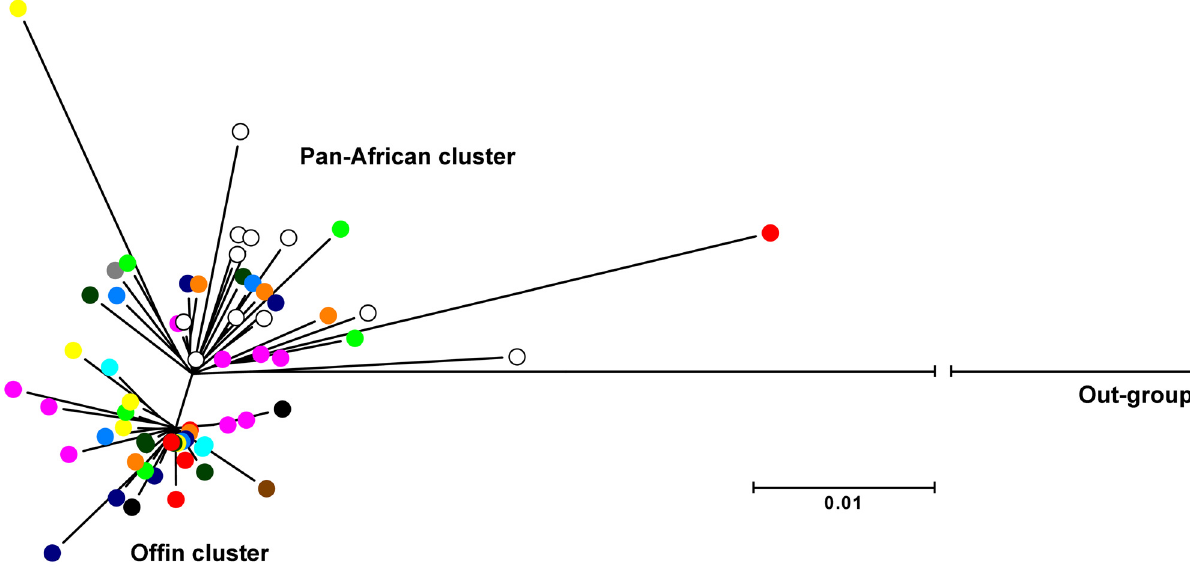
Fig 4. Phylogenetic reconstruction of HBV/E sequences. A maximum-likelihood phylogenetic tree based on the pre-S/S gene region sequence (1,200 bp) was constructed using the Kimura 2-parameter +G model [41] embedded in MEGA6 [42]. While HBV sequences obtained in this study are indicated as multicolored dots (according to village of residence), HBV genotype E sequences retrieved from GenBank are depicted as empty circles (accession numbers (origin): AB205192 (Ghana), AB106564 (Ghana), DQ060830 (Madagascar), AB201290 (Benin), AB205188 (Ghana), AB091255 (Côte d'Ivoire) AB091256 (Côte d'Ivoire), HM363611 (Nigeria), FN594765 (Niger), AB205191 (Ghana), AB205190 (Ghana)). The sequence of the genotype D AY233291 from South Africa was included as an